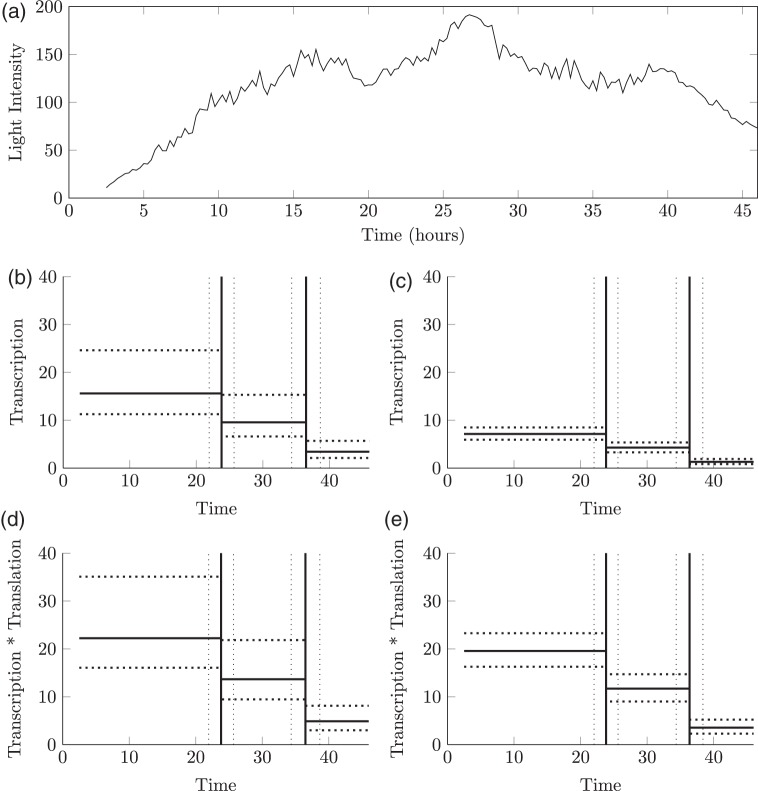
(a) The raw time course data for a single cell from the mature tissue sample, with the backcalculated transcriptional profile given in (b) under the LNA and in (c) under the BDA. The reparameterized profile of transcription \documentclass[12pt]{minimal}
\usepackage{amsmath}
\usepackage{wasysym}
\usepackage{amsfonts}
\usepackage{amssymb}
\usepackage{amsbsy}
\usepackage{upgreek}
\usepackage{mathrsfs}
\setlength{\oddsidemargin}{-69pt}
\begin{document}
}{}$\times$\end{document} translation, \documentclass[12pt]{minimal}
\usepackage{amsmath}
\usepackage{wasysym}
\usepackage{amsfonts}
\usepackage{amssymb}
\usepackage{amsbsy}
\usepackage{upgreek}
\usepackage{mathrsfs}
\setlength{\oddsidemargin}{-69pt}
\begin{document}
}{}$\alpha \beta$\end{document} is given in (d) for the LNA and (e) for the BDA. Dashed lines represent the 95% credible intervals about the posterior median transcriptional switches (vertical lines) and transcriptional rates (horizontal lines).